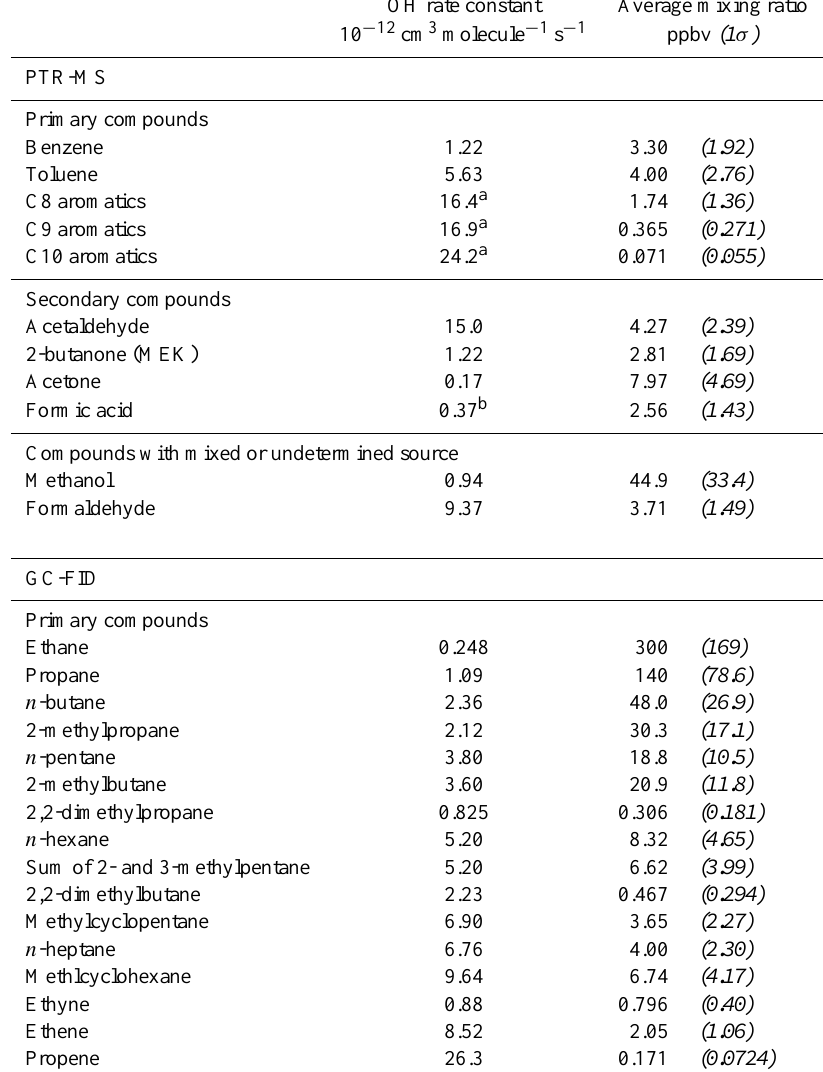
Table 1. Compounds analyzed. The italicized data are 1 standard deviation (1 σ ) of the average mixing ratio, as indicated in the units – ppbv (1 σ ) – beneath the “average mixing ratio”